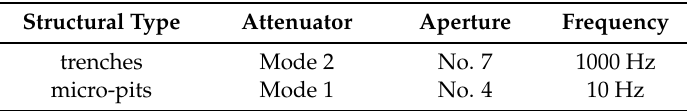
Table 1. The main parameters of two micromachining type.